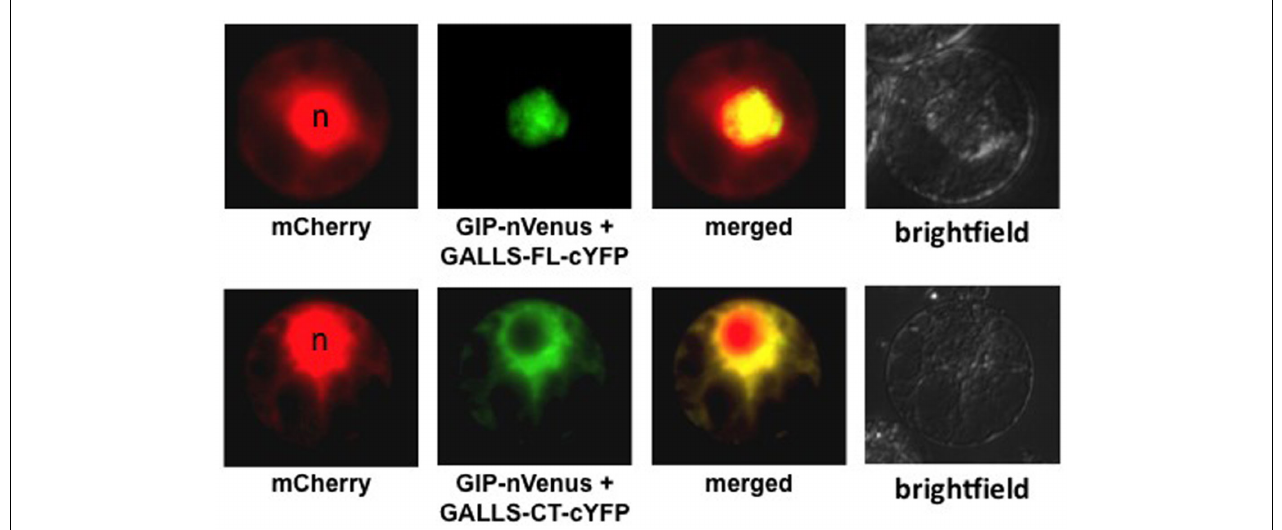
were imaged by epifluorescence microscopy 18h later. mCherry marks both the nucleus and the cytoplasm. GIP-nVenus interacts with GALLS-FL-cYFP (upper row) or with GALLS-CT-cYFP (lower row) to restore fluorescence using BiFC. n Indicates the nucleus. Data courtesy of Dr.YalingWang.